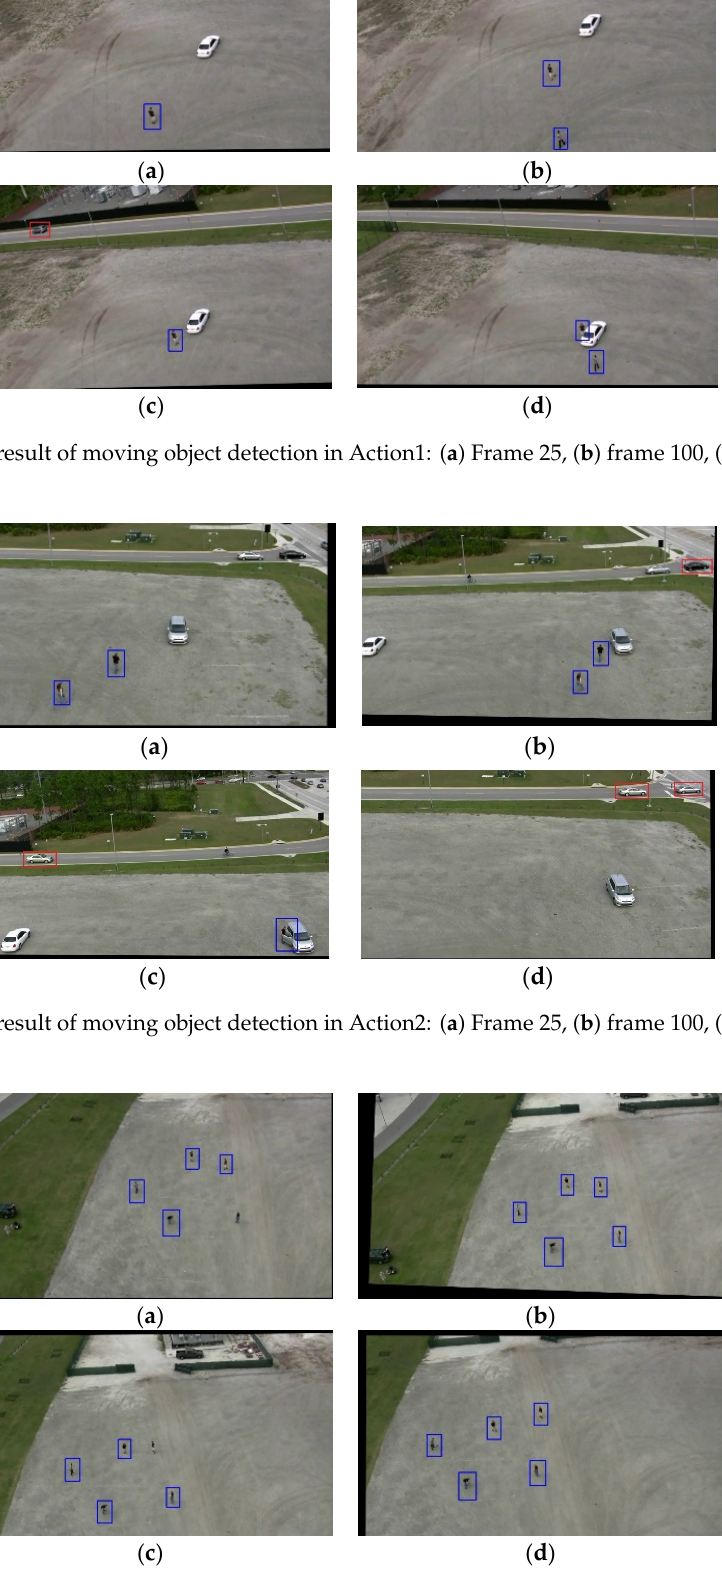
Figure 12. The result of moving object detection in Action3: ( a ) Frame 5, ( b ) frame 60, ( c ) frame 120, ( d ) frame 300.